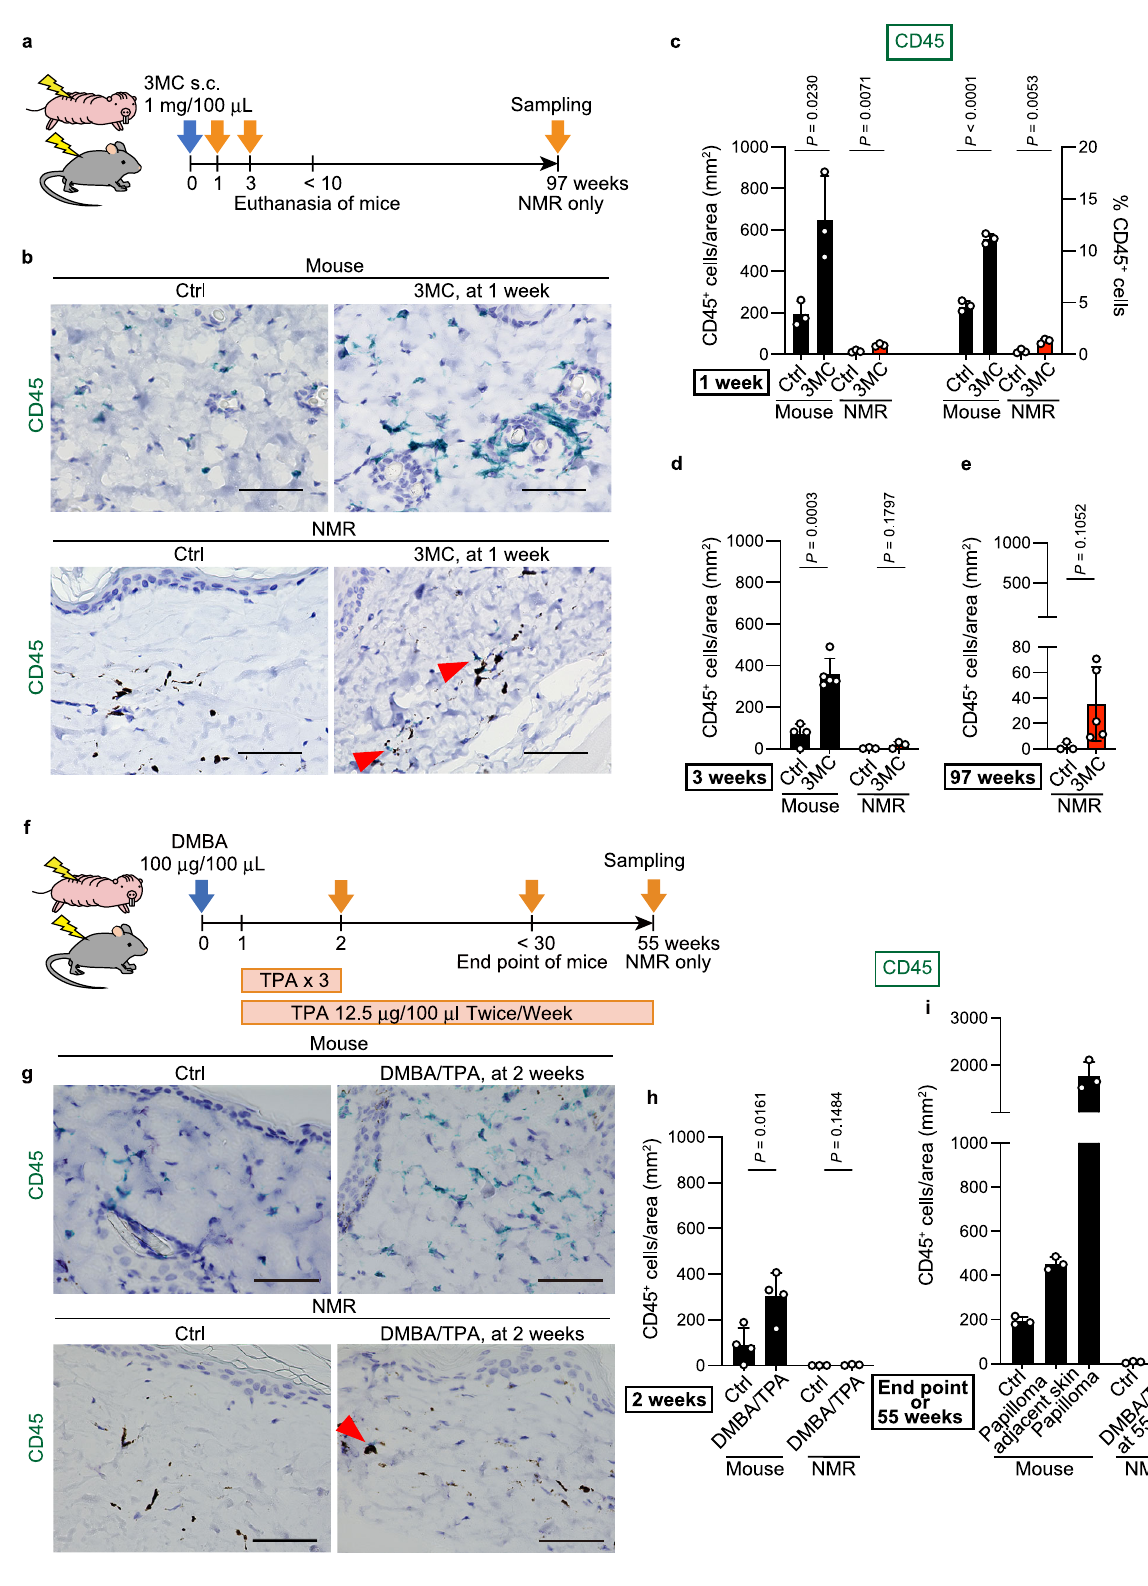
Fig. 12a, b and Supplementary Data 1). Cell type